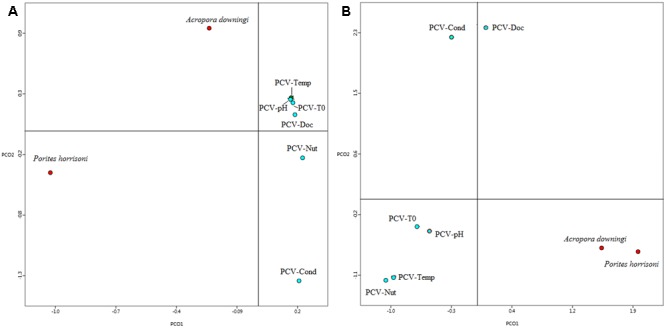
First two principle coordinates from the principal coordinate analysis of the viral communities from the Gulf coral viromes and Pacific coral virome (Vega Thurber et al., 2009b) as produced from the MG-RAST analysis for the (A) functional genes where protein-encoding sequences were analyzed using BLASTX (E-value < 10-5) to the subsystem database and grouped according to the highest hierarchal metabolic function or ‘subsystem. PCV1, pacific coral virome generated from stressed coral holobiont project; Temp, temperature; T0, control; Nut, nutrient; Cond, conductivity; DOC, dissolved organic carbon. (B) Best hit of viral classification.